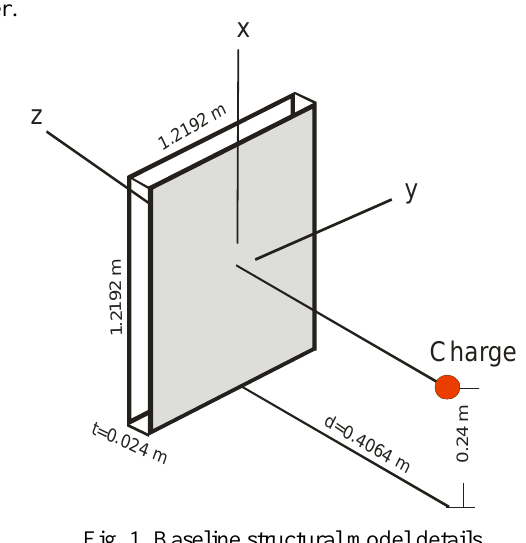
Fig. 1. Baseline structural model